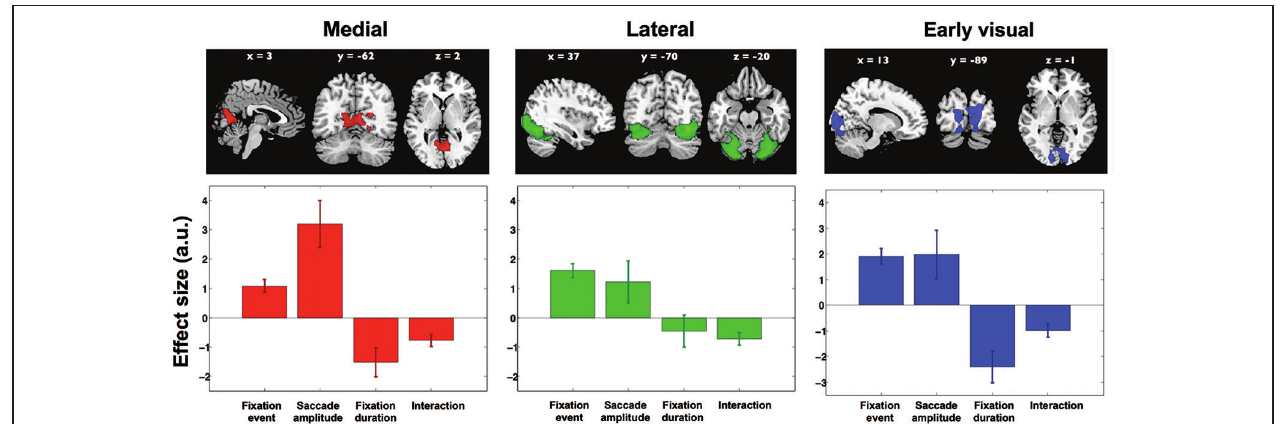
FIGURE 6 | Results from ICA . Three independent component maps reflecting visual cortex, and their average beta weights in the fixation duration and saccade amplitude models. Out of 30 components these remained significant with the direct comparison of scanning and inspection. Brain maps were thresholded at Z > 2.5. Lower graphs